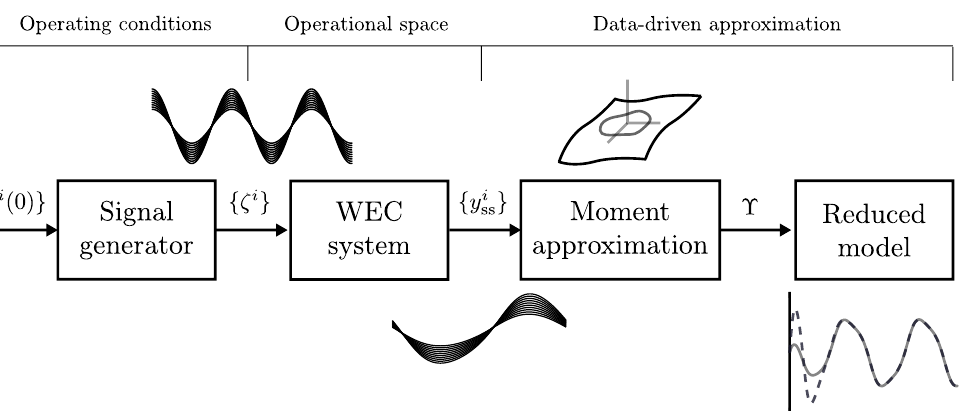
Figure 2. Schematic representation of the model reduction by moment-matching procedure described throughout Section